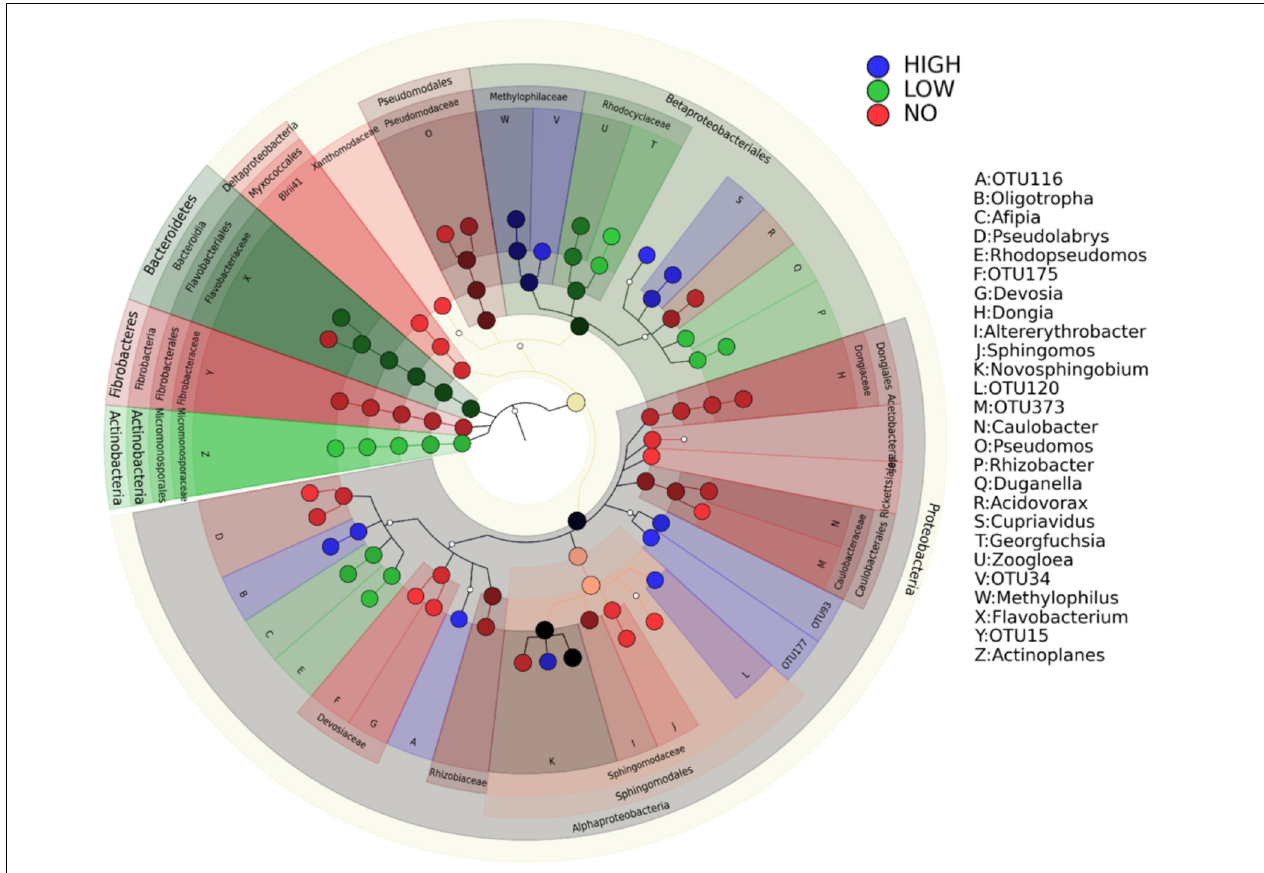
FIGURE 6 | Biomarkers of the endophytic community of roots exposed to high and low concentration of pollutants and of the roots in unpolluted treatments. LEfSe was used to validate the statistical significance and the size effect of the differential abundances of taxa (Kruskal–Wallis and Wilcoxon rank-sum p < 0.05 and LDA score > 3.5). In the cladogram, the class, order, and family are presented and the genus is represented using letters.